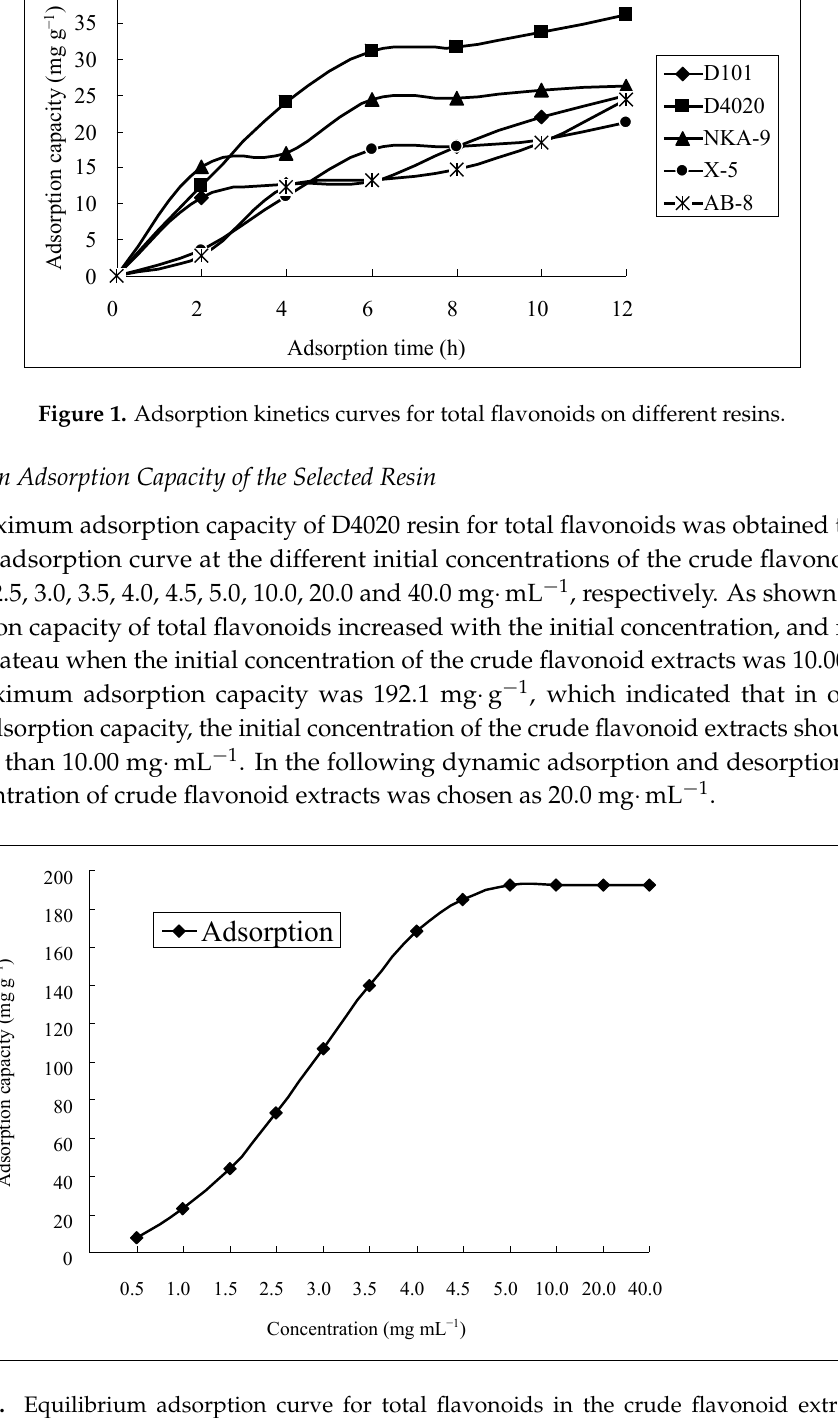
Figure 2. Equilibrium adsorption curve for total flavonoids in the crude flavonoid extracts on D4020 resin.